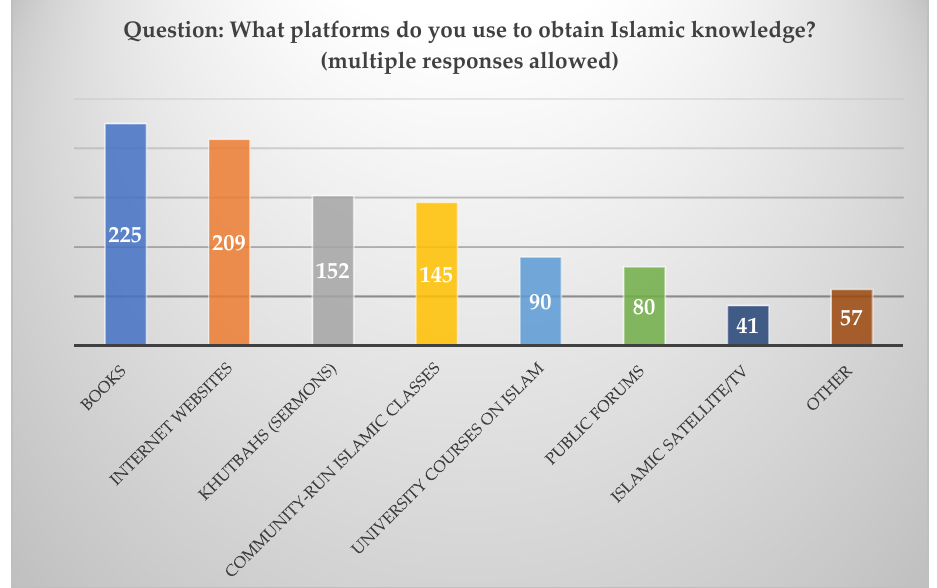
Figure 2. Platforms used to obtain Islamic knowledge.